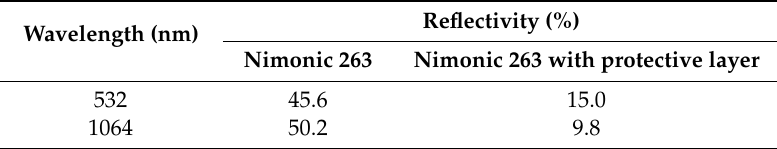
Table 3. Reflectivity of Nimonic 263 with and without protective paint